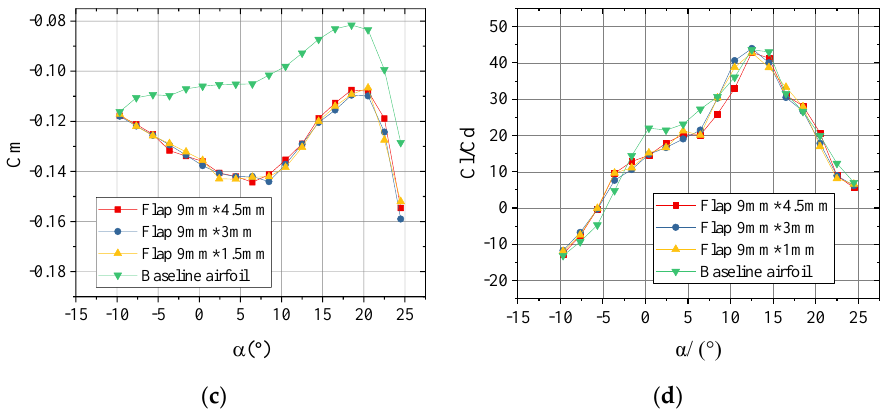
Figure 15. Variation of the aerodynamic characteristics with different thicknesses of Gurney flaps (T.I. of 19%, Re: 0.8 × 10 6 ). ( a ) Lift coefficient comparison; ( b )drag coefficient comparison; ( c ) pitching-moment coefficient comparison; ( d ) lift-to-drag ratio comparison.